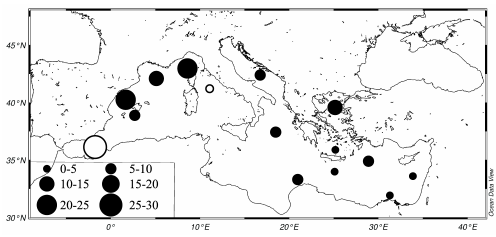
Fig. 16. Spatial distribution of total mesozooplankton abundance (black circles) or total copepod abundance (open circles) (10 4 × ind. m − 2 ) in spring time in the 0–200 layer of MS. Sources: Benovi´c et al., 2005 (Adriatic Sea); Christou et al., 1998 (South of Crete, Rhodos gyre); Fern´andez de Puelles et al., 2004 (0–100m layer, Balearic Islands); Gaudy and Champalbert, 1998 (Gulf of Lion); Mazzocchi et al., 2003 (Ionian Sea); Mazzocchi, unpublished data (North Balearic Sea); Pasternak et al., 2005 (0–150m layer, Cyprus Eddy); Pinca and Dallot, 1995 (Ligurian Sea); Porumb and Onciu , 2006 (offshore Lybia); Saiz et al., 1999 (Catalan Sea); Scotto di Carlo et al., 1984 (Tyrrhenian Sea); Seguin et al., 1994 (Alboran Sea); Siokou-Frangou, unpublished data (Aegean Sea); Zakaria, 2006 (0–100m layer, offshore